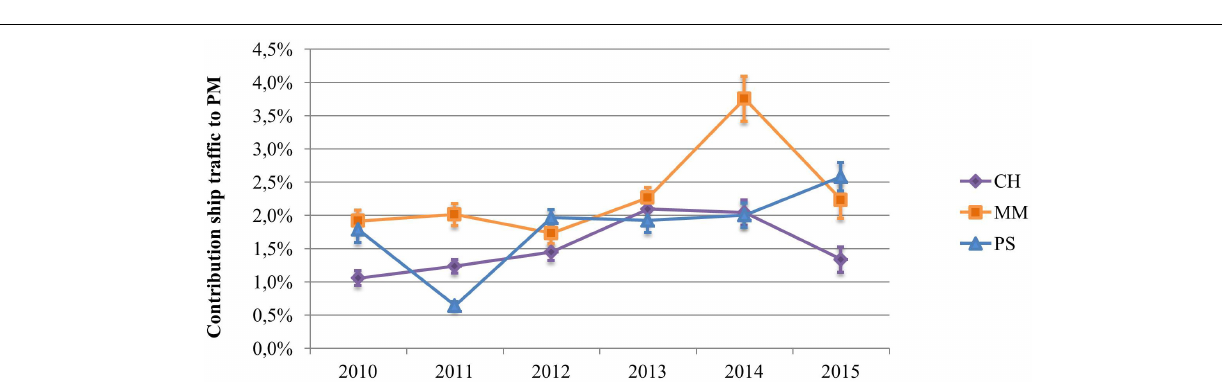
contribution of the factor was higher in CH (32%) with respect to MM (21%) and PS